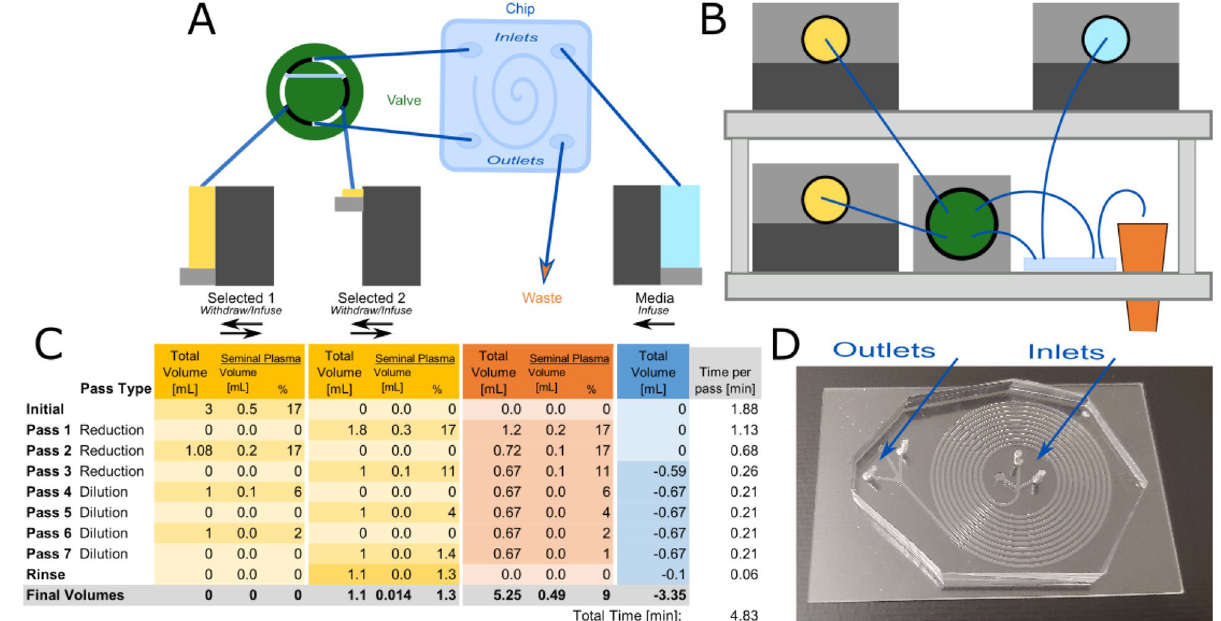
Figure 2. Automated Instrument and Protocol. ( A ) The components of the automated platform are shown, including three syringe pumps, one valve, one microfluidic chip, and a waste outlet. ( B ) The layout of the components in the instrument is presented. Although the valve and microfluidic chip are enlarged for clarity, the whole instrument is 30 ″ wide and 18 ″ tall. ( C ) Protocol to operate automated instrument. The initial sample contains 2.5 mL of media and 0.5 mL of seminal plasma (3 mL total). Each row represents the fluid volumes as measured after each pass of the spiral channel. Negative values in the Table represent fluid infused from the media portion into the system. ( D ) Photo of microfluidic